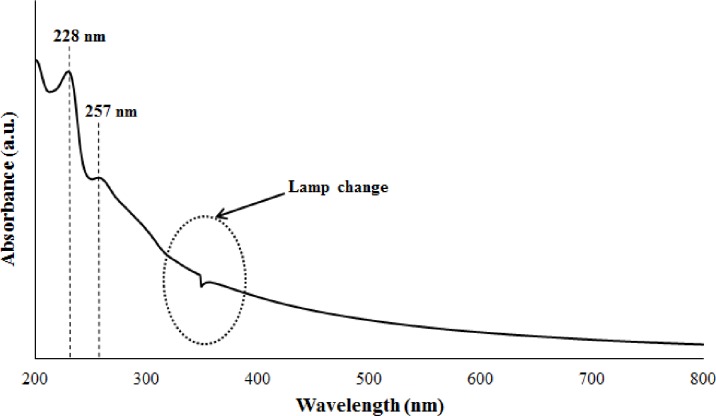
UV-Vis spectrum for crude O/W emulsion (264 mg L-1).